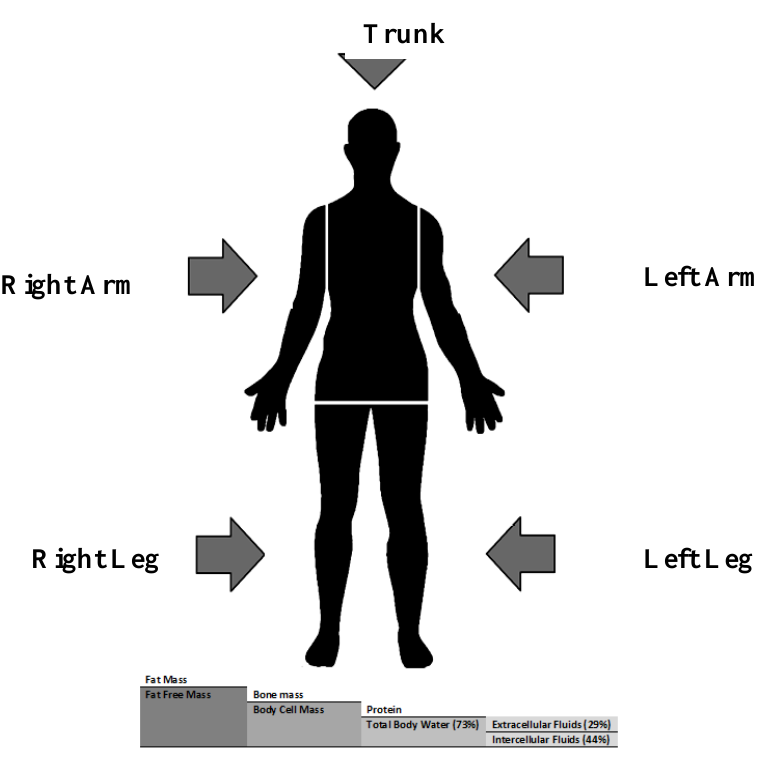
Figure 1. Main body segments and